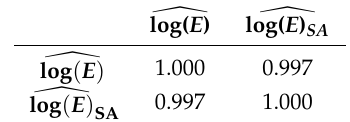
Note: SA denotes seasonally adjusted values. (cid:92) (cid:100) CE p CE p , SA